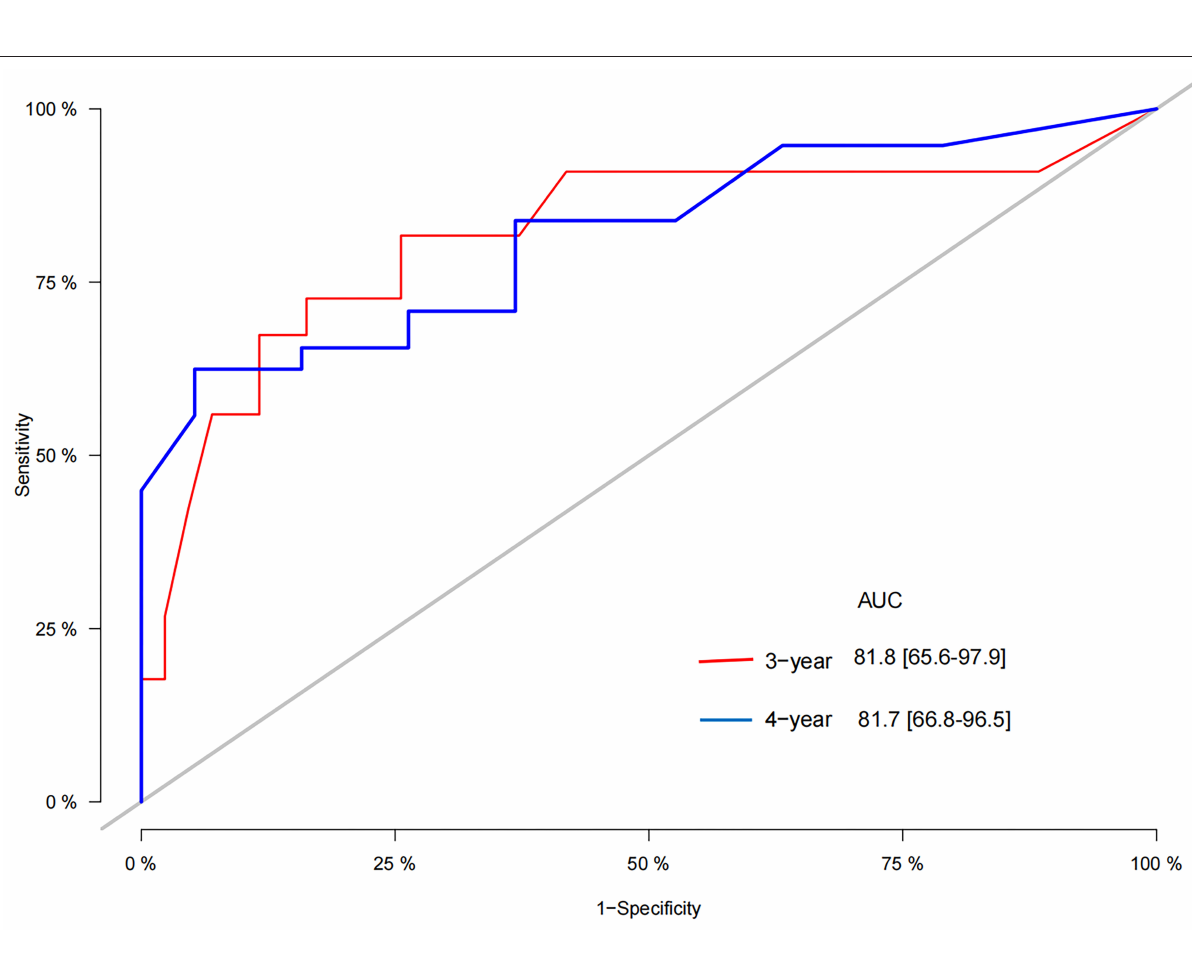
Frontiers in Public Health |